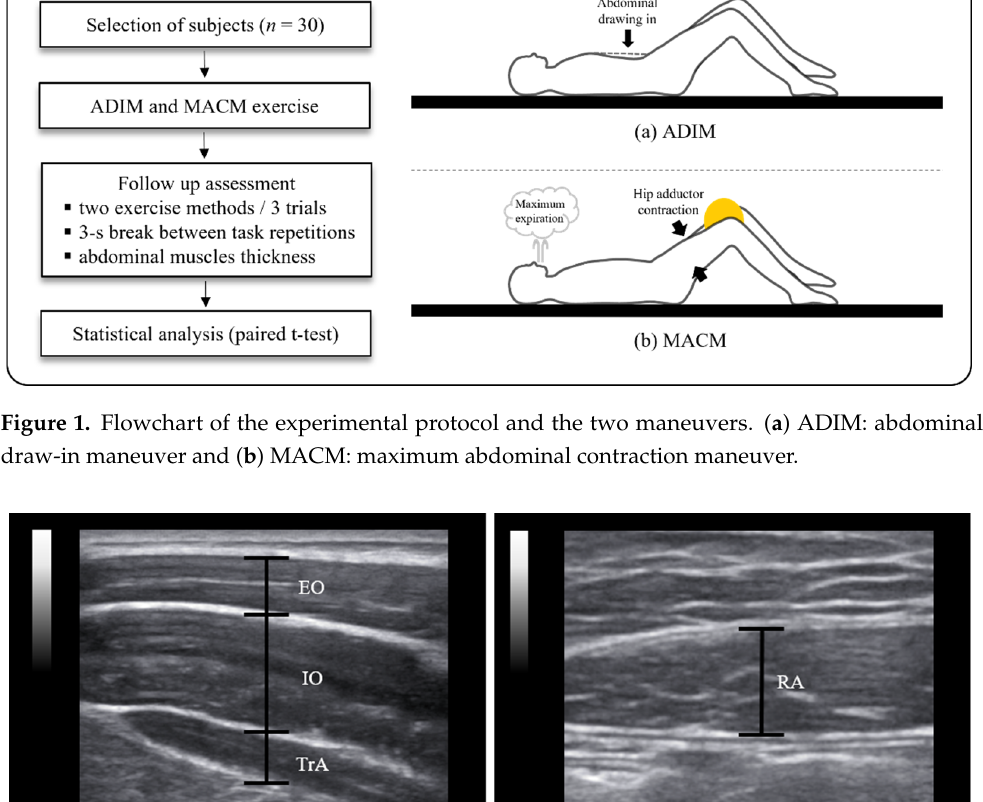
Figure 1. Flowchart of the experimental protocol and the two maneuvers. ( a ) ADIM: abdominal draw-in maneuver and ( b ) MACM: maximum abdominal contraction maneuver.